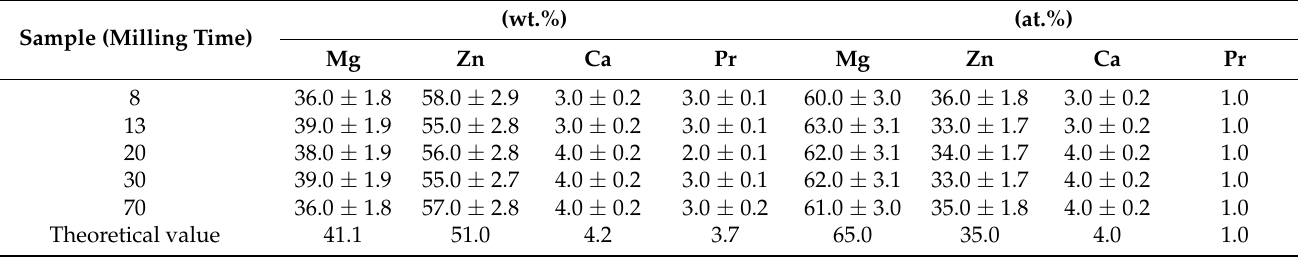
Figure 9. Morphology of the polished sintered specimens for the Mg-Zn-Ca-Pr alloy milled for ( a ) 13, ( b ) 20, and ( c ) 70 h. Table 6. EDS results from the Mg-Zn-Ca-Pr powder alloy samples milled for 8, 13, 20, 30, and 70 h,